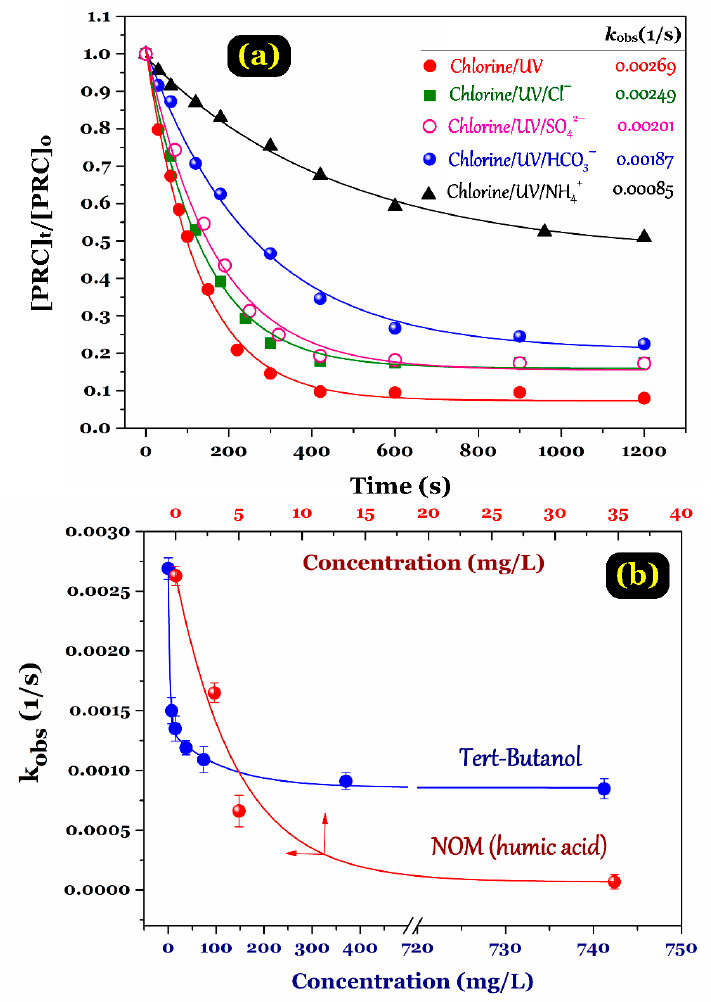
Figure 6. ( a ) Effect of some co-existing inorganic ions on the PRC degradation efficiency and rate (concentrations of each ion: 100 μ M); and ( b ) effect of co-existing NOM (humic acid) and a • OH scavenger ( tert -butanol) on the PRC degradation rate constant (experimental conditions: [PRC] o ≈ 10 μ M, [NaClO] o = 100 μ M, pH = 7.0, and UV photon fluxes = 3.14 × 10 − 6 photon fluxes).